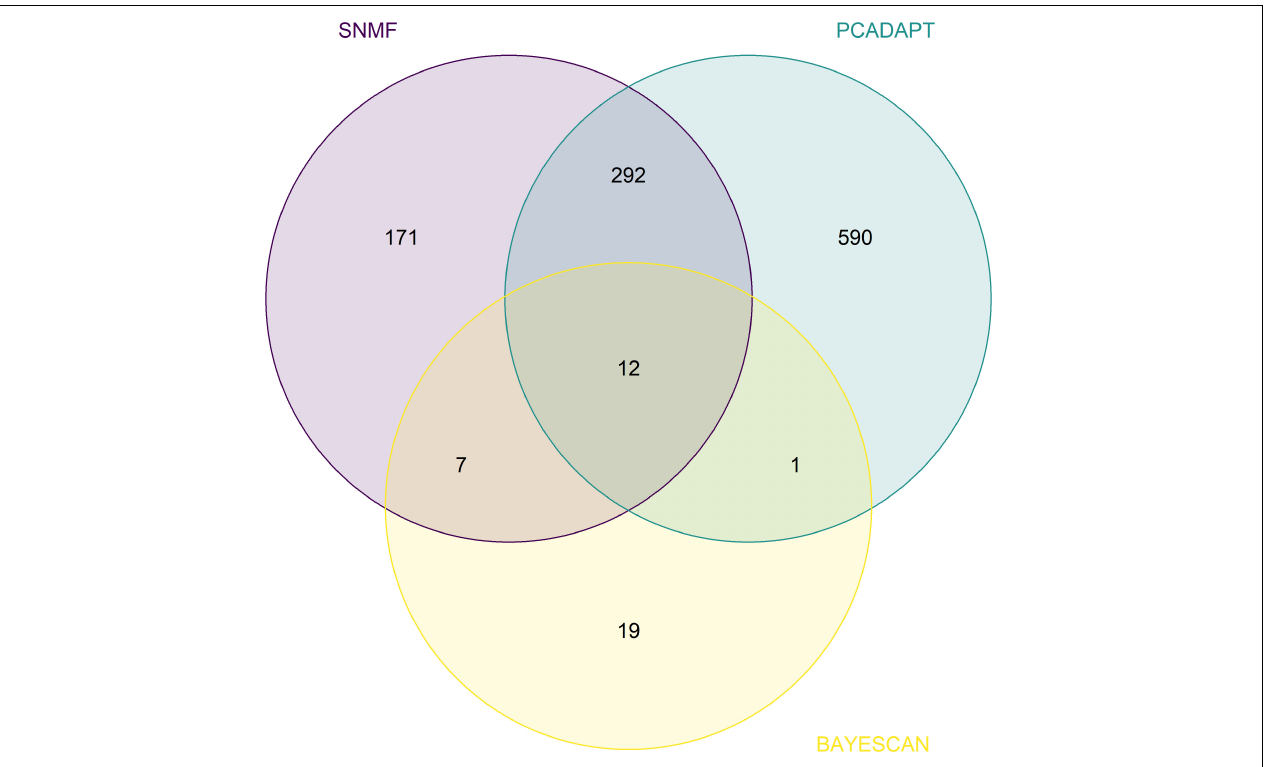
FIGURE 3 | Venn diagram denoting overlap between SNPs identified as an outlier with sNMF, Pcadapt, and BayeScan. The set of putative selected SNPs was built by considering the 12 SNPs shared among these three methods.